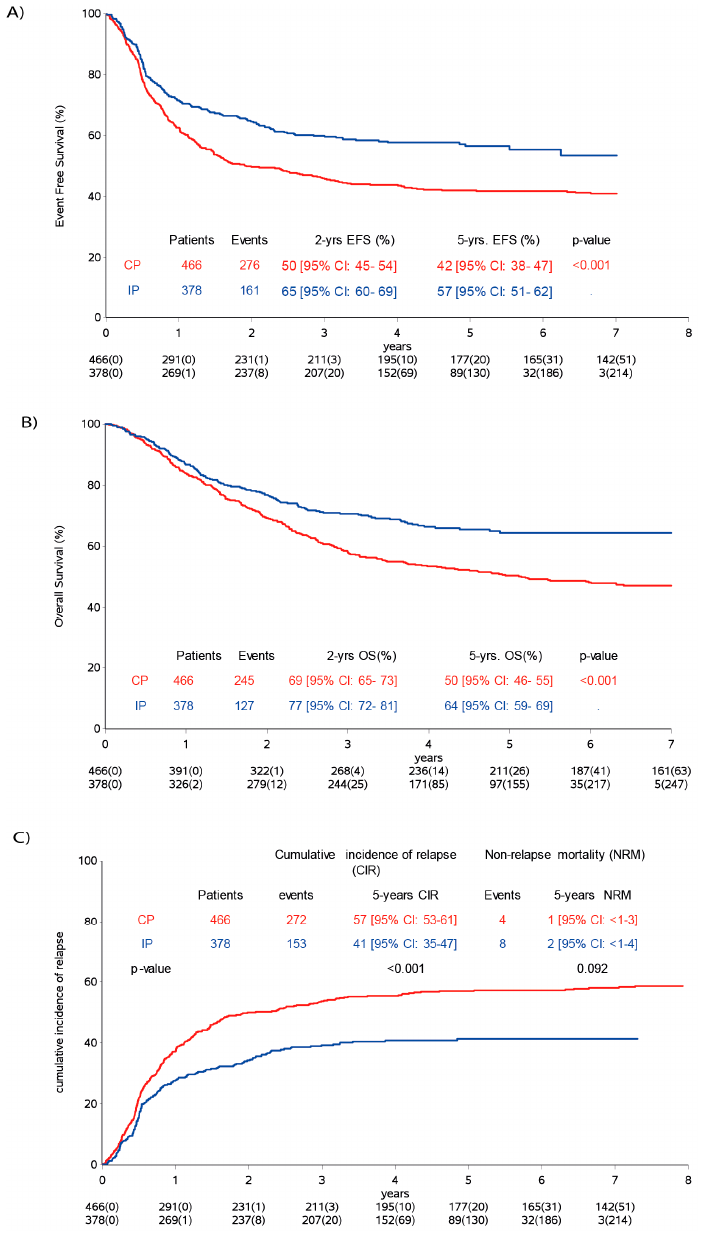
Figure 2. Analysis population comparing control population versus immunotherapy population. ( A ) Event-free survival, ( B ) overall survival and ( C ) cumulative incidence of progression/relapse. CP (control population), IP (immunotherapy population), CIR (cumulative incidence of relapse) and NRM (non-relapse mortality).